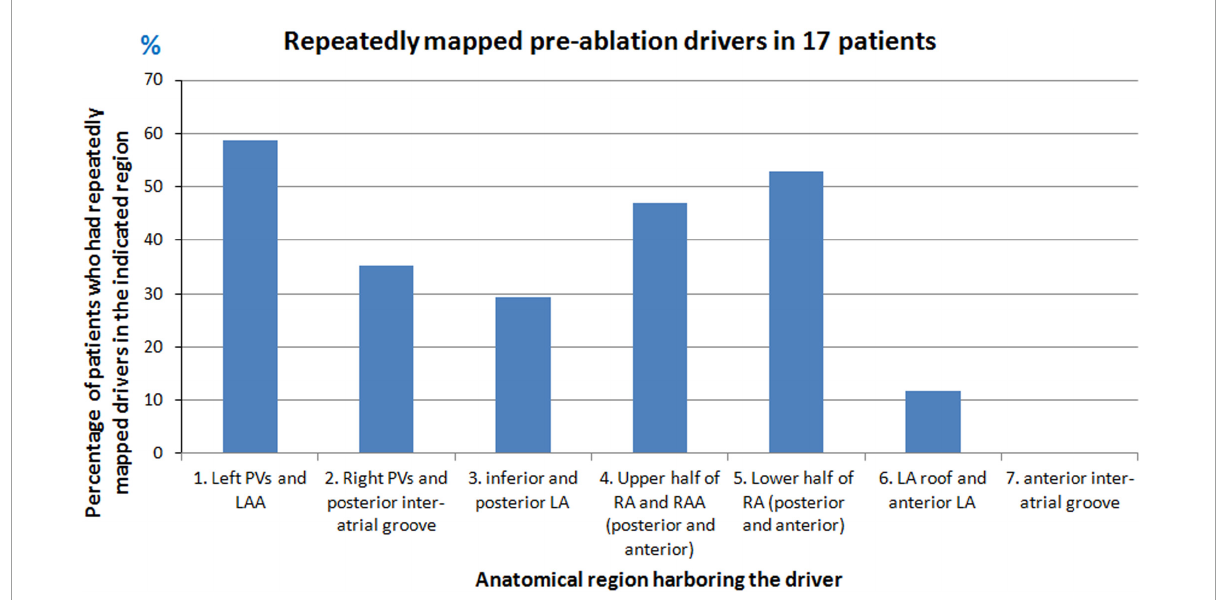
FIGURE2 Repetitive sources mapped during pre-ablation persistent AF. Graph shows the percentage of patients who had repetitive drivers from different anatomical regions of the atria during pre-ablation AF.